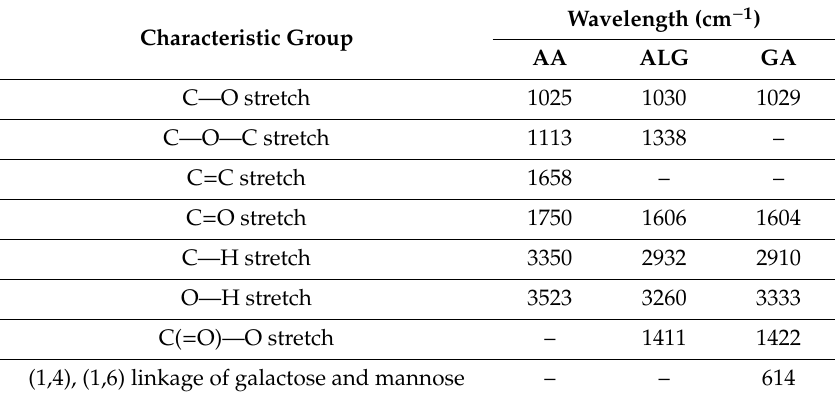
Table 4. Positions of major IR stretching bands and their respective assignments for AA, ALG and GA. Characteristic Group